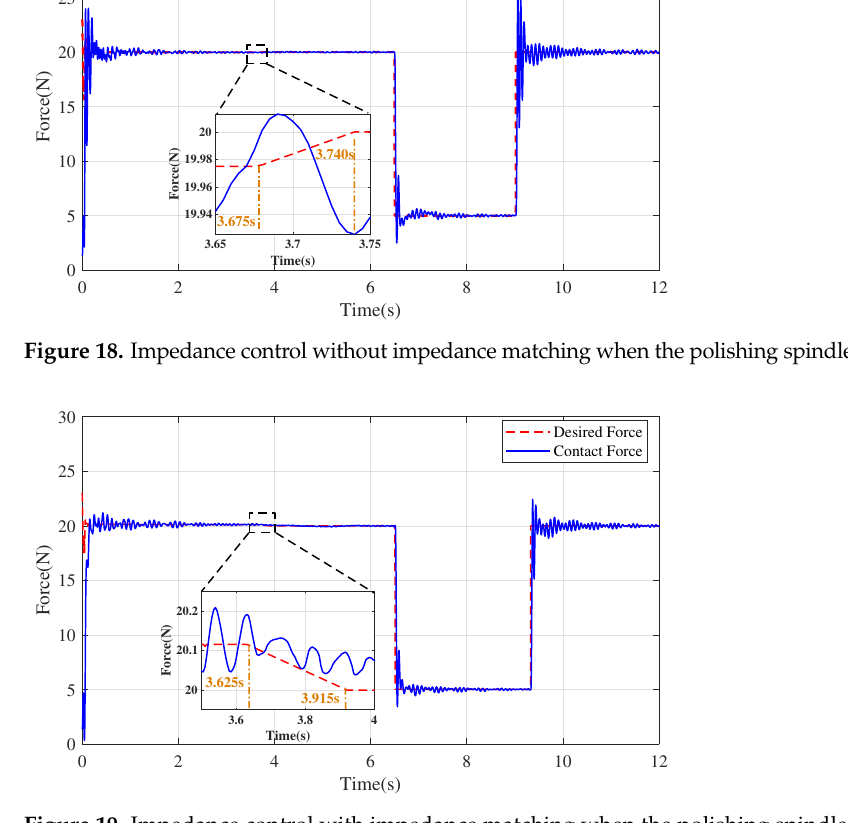
force control is adopted, the vibration of contact force decreases obviously with impedance matching in the whole polishing